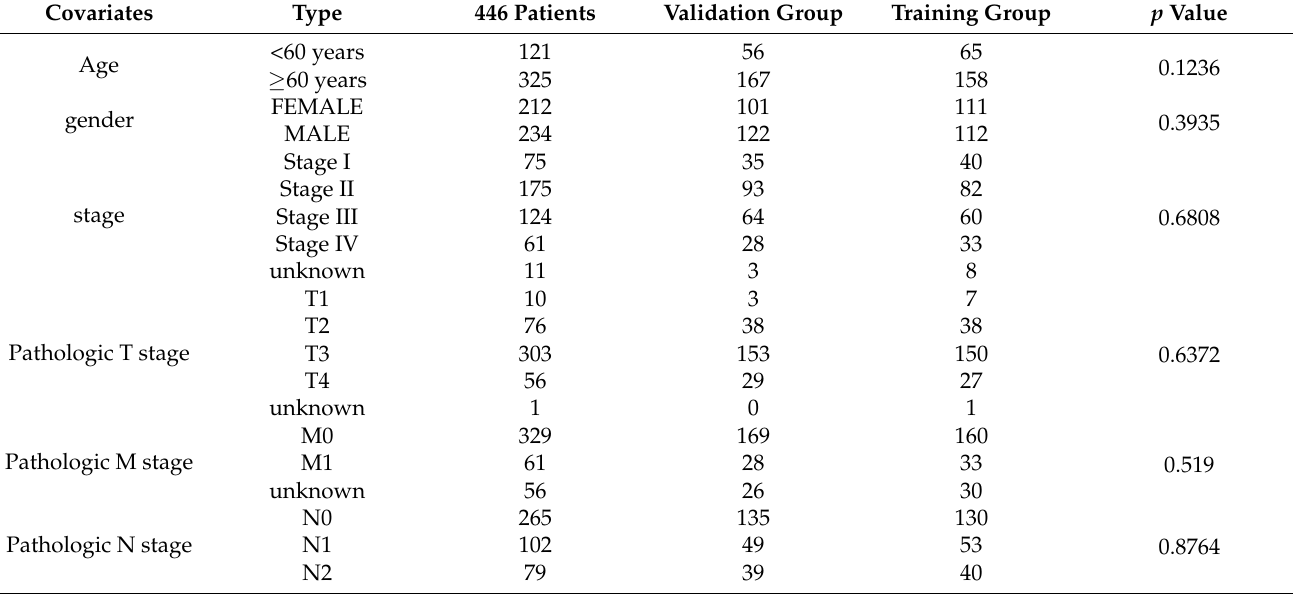
Table 2. Specific baseline clinical characteristic of 446 COAD